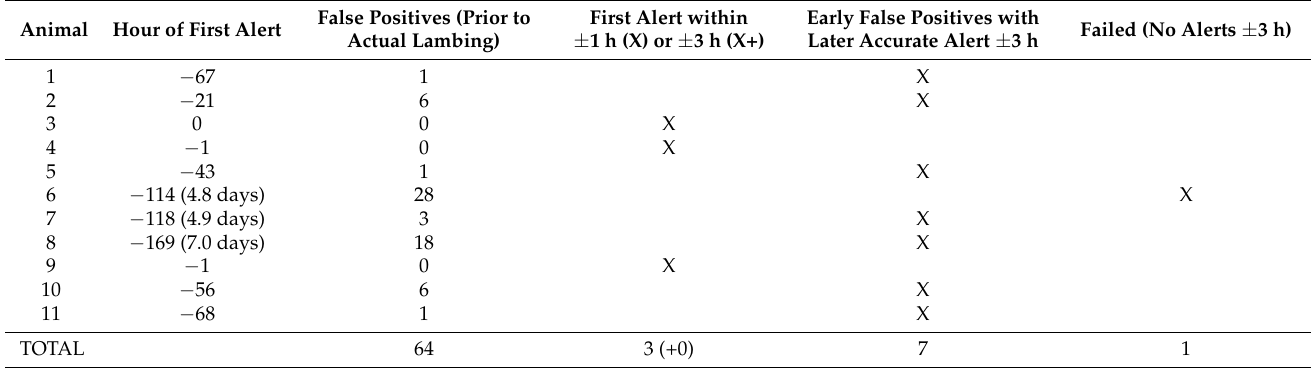
Table 4. Application of the integrated support vector machine (SVM) to the validation dataset (Trial Two). Hour of first alert is expressed relative to the recorded hour of birth. Notations “X” and “X+” indicate the animal meets the criteria. Animal Hour of First Alert